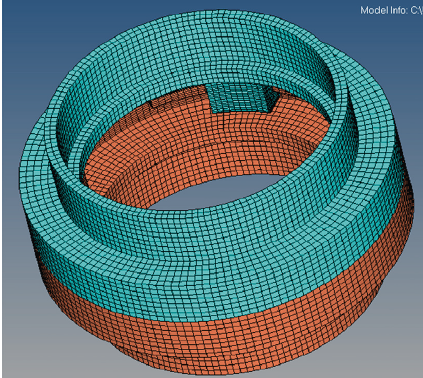
Figure 7: Assembly meshing diagram.